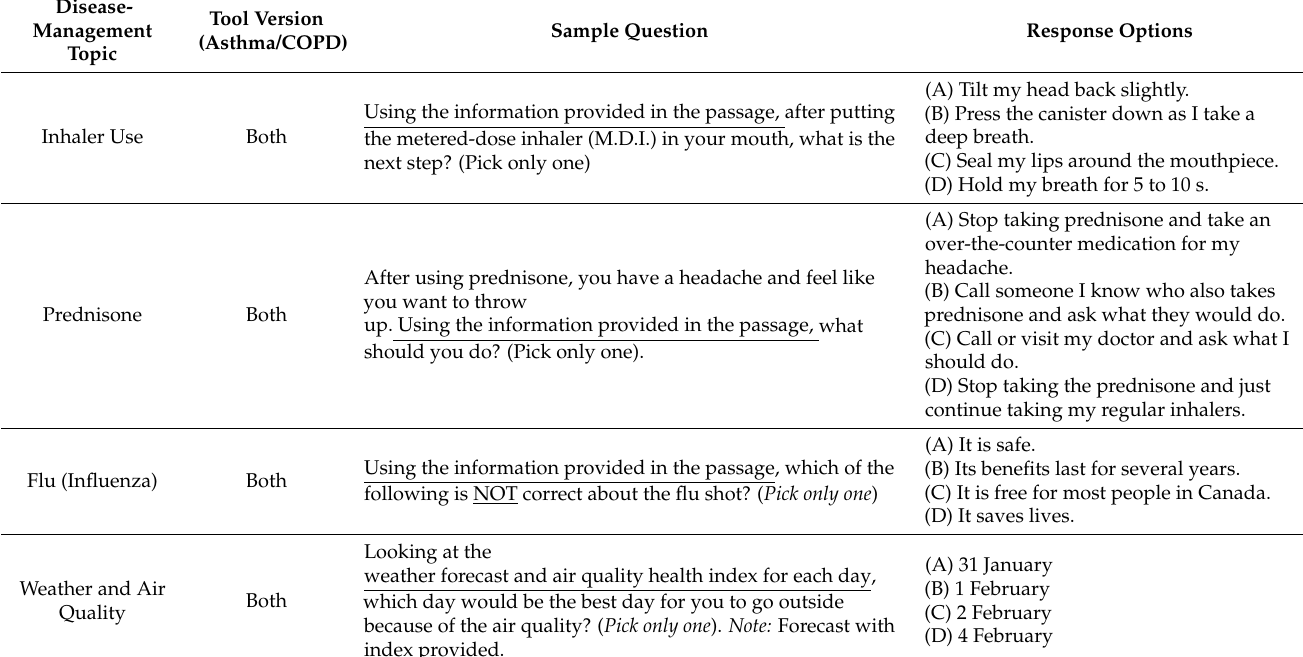
Table 1. The 12 disease-management topics with sample corresponding questions and response options. Disease-